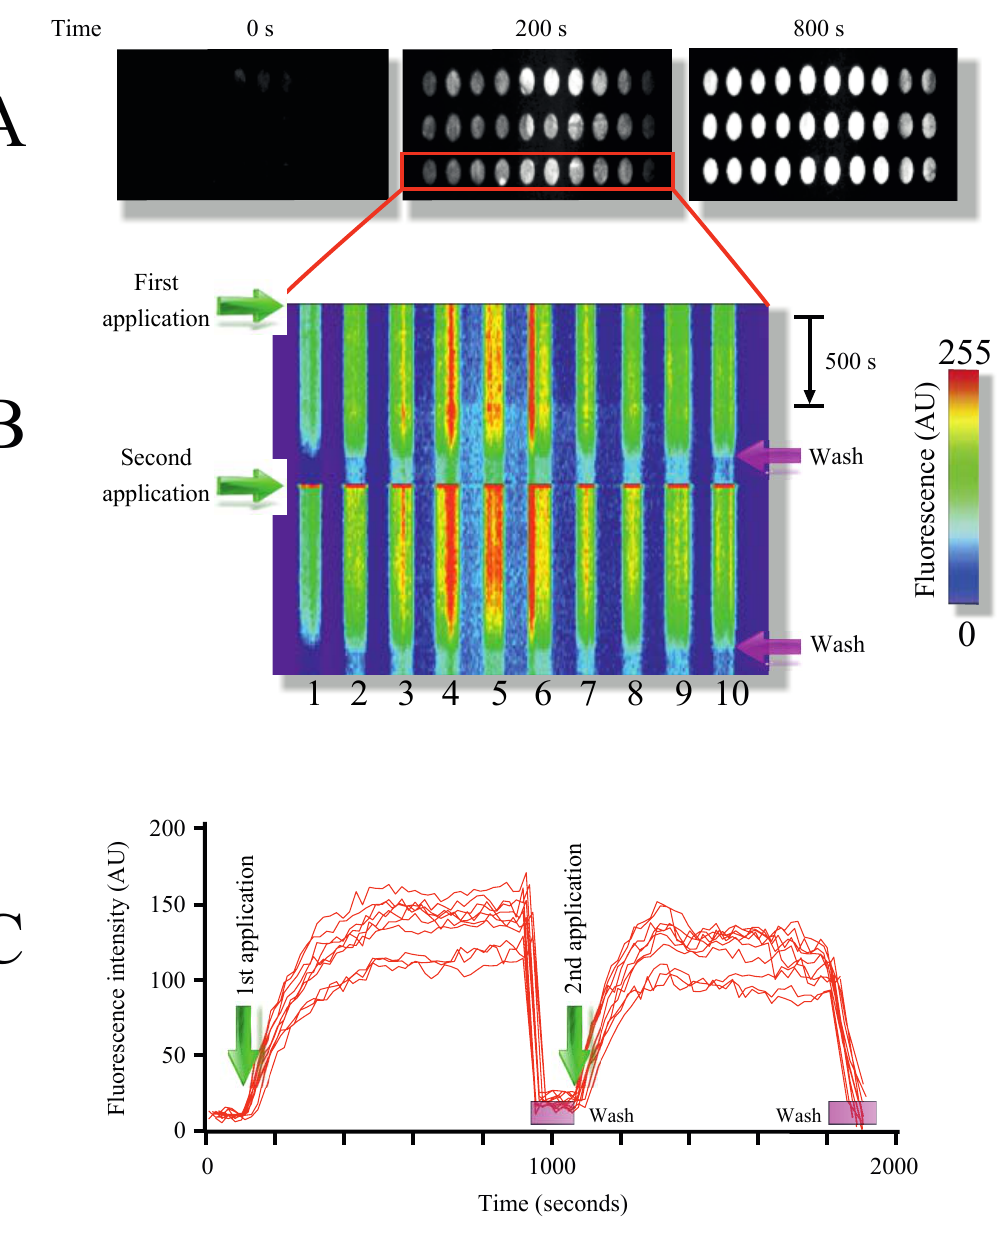
Figure 2. Typical microarray experiment using the LG-TIRF-MB system. ( A ) Picture of the viewing area accessible to the 2x objective (the image shows 30 spots). ( B ) Time course of the microarray activation upon DNA sample addition. Notice the reproducibility of the response when all spots show increments in fluorescence with similar time courses. The fluorescence was plotted X-Y and time to illustrate the entire experiment in one image. Pseudo-color was used to evidence all changes in fluorescence (scale shown on the right). Green arrows point to the time of DNA sample application and fuchsia arrows indicate the time of microarray reconstitution (Wash). For simplicity in this particular experiment the microarray was reconstituted twice, even though we have accomplished near to 10 times reutilization of the same microarray. ( C ) Time courses showing changes in mean fluorescence of each spot as lines. First and second sample application are indicated with green